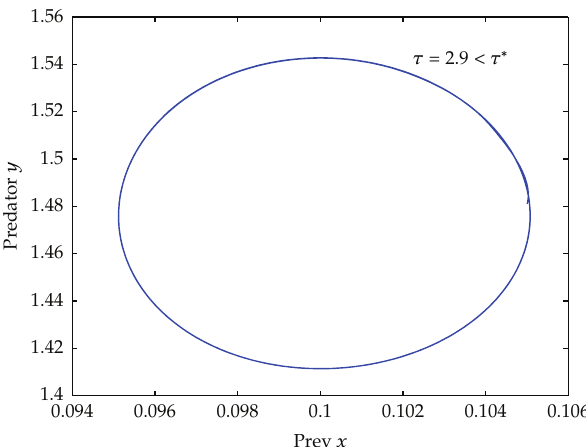
(cid:2) τ (cid:5) . 0